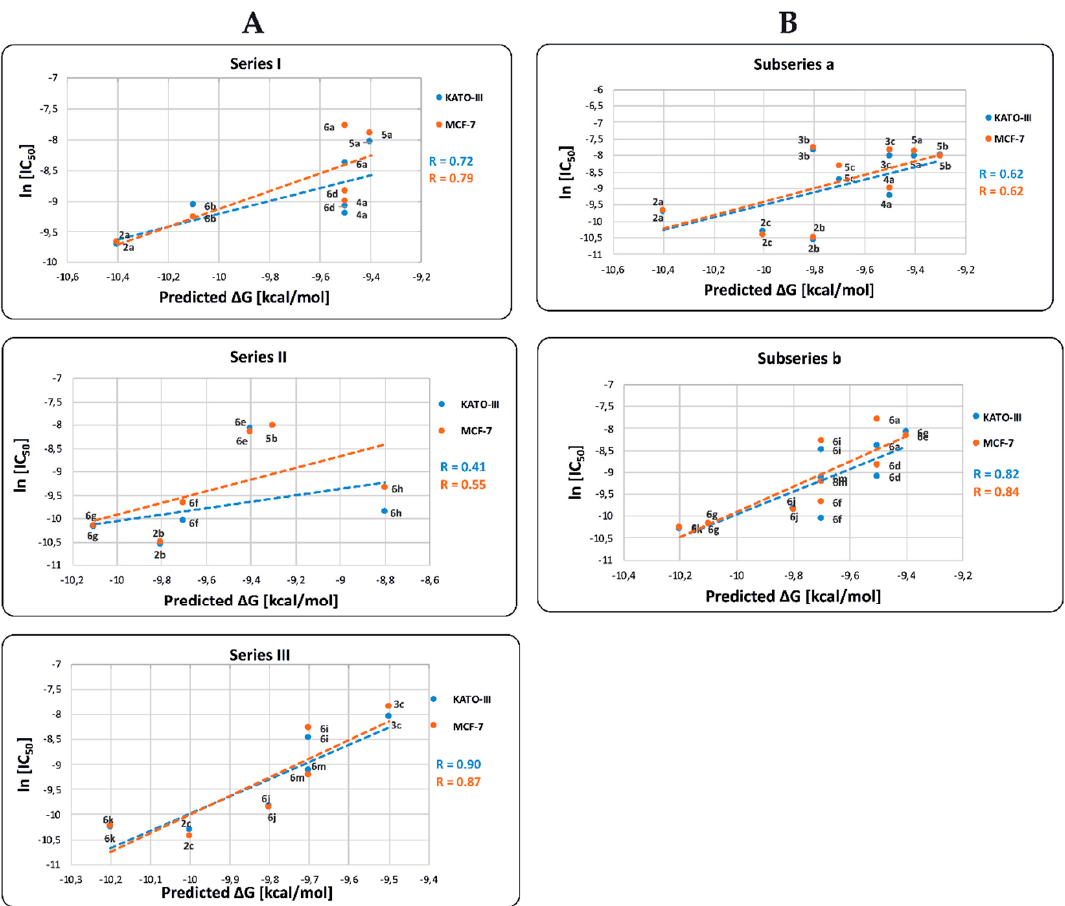
Figure 5. Relationship between ln[IC 50 ] and binding free energy ( ∆ G bin ) values of BIZQs for: ( A ) Series I (BIZQs that have no substituent at N), II (BIZQs that have a 2-hydroxyethyl group), and III (BIZQs that contain a 2-acetoxyethyl group); ( B ) subseries a (simpler BIZQs) and b (conjugated amino acids BIZQs) with COX-2 protein. Compounds 3a and 6c (Series I), 3b and 4b (Series II), 4c and 5c (Series III), 3a , 4b and 4c ( subseries a ) and 6b , 6c and 6h ( subseries b ) were excluded from the statistical analysis because they are outlier data points that significantly a ff ect the correlation ln[IC 50 ] versus ∆ G bin . Furthermore, pIC 50 values are also positively correlated with the predicted cLogP values (Figure